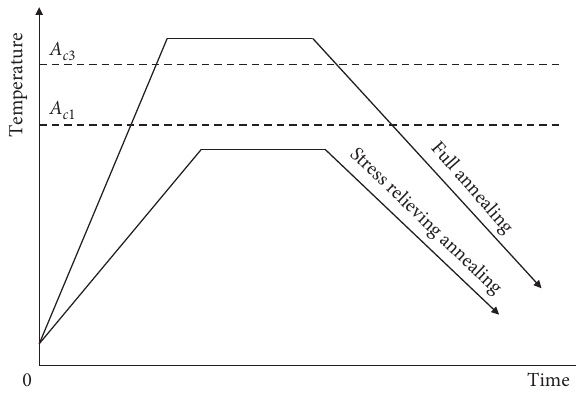
Figure 1: Annealing process. Table 1: Chemical composition ∗ of S350, S420, and G500